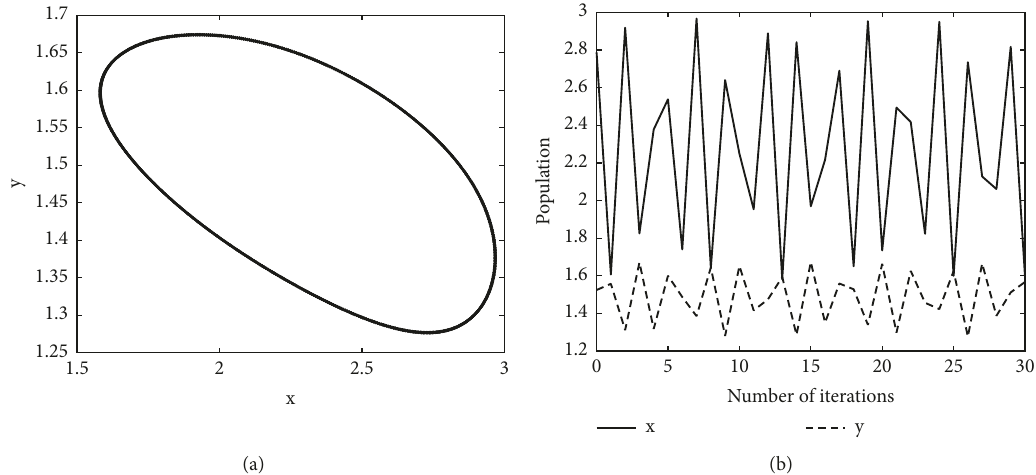
Figure4:(a)AninvariantcurvejustbeyondNeimark-Sackerbifurcationthreshold.Parametervalues (𝐹,𝐺) = (43,5) .(b) 𝑥 and 𝑦 asfunctions of time in the case (𝐹,𝐺) = (43,5) .